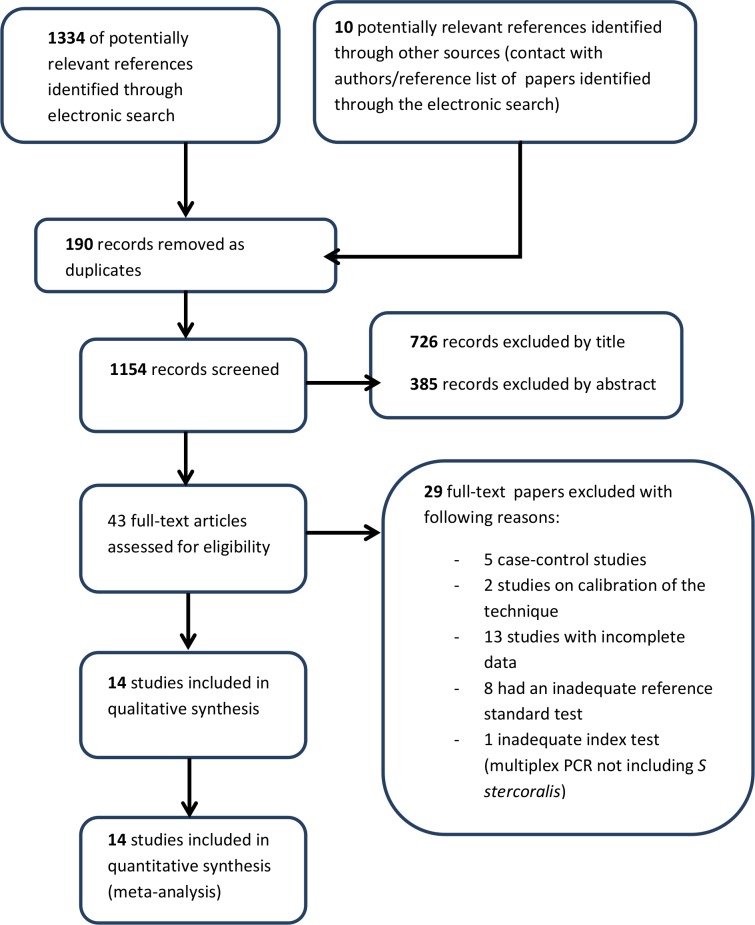
Study flow chart.